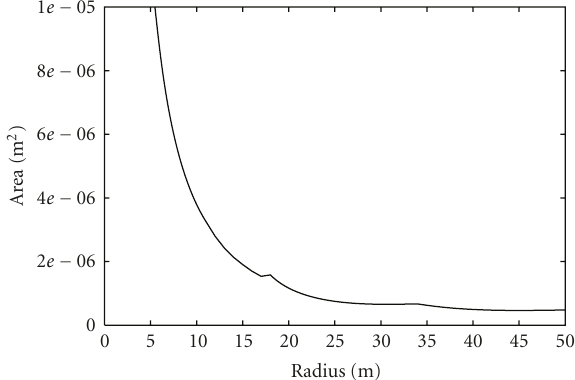
Figure 10: Percentage of covered surveillance area for three receivers as a function of the angle θ and of the radius r ( P t = P t R = 50 m).